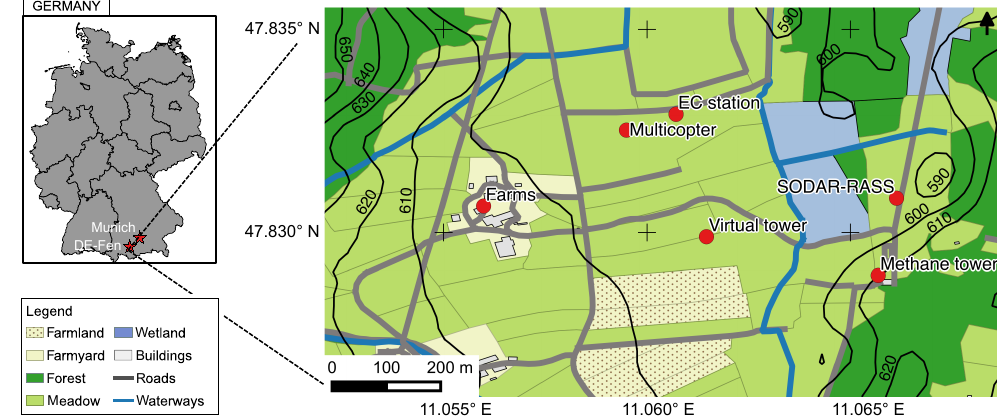
Figure 1. Measurement site DE-Fen, Germany, with land use and ground-based instrumentation important for this study during the ScaleX- 2015 campaign. Contour lines stand for altitude (m) above sea level (QGIS, OpenStreetMap).